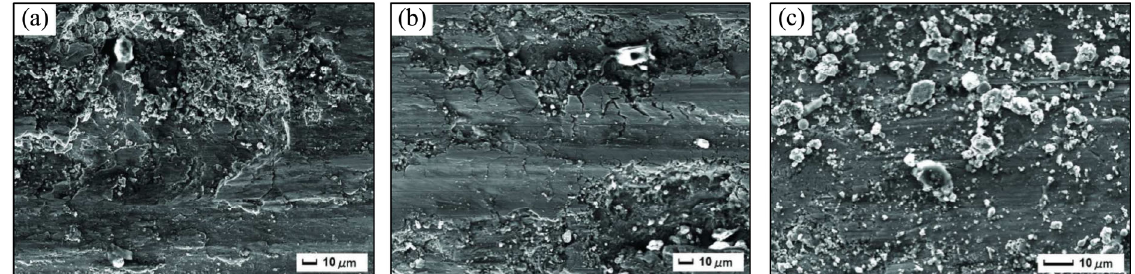
Fig. 21 SEM metallographic images of worn-pin surfaces pertinent to Ti64 specimens at distinct dry sliding speeds: (a) 0.75 m·s − 1